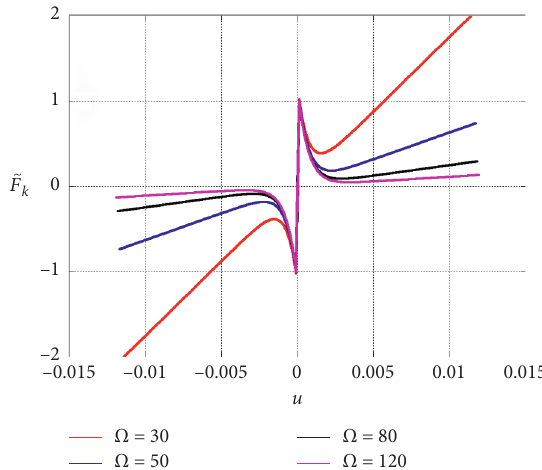
Figure 8: Absolute acceleration shock spectrum of the NSA. (a) Different shock excitation amplitude % F , % A � 1, μ � 6 . 7 × 10 − 4 , ζ � 0. (b) Different preload amplitude % A � 1, μ � 6 . 7 × 10 − 4 , % F � 50, ζ � 0. (c) Different fitting values μ , % A � 1, % F � 50, ζ � 0. (d) Different damping ratio μ � 6 . 7 × 10 − 4 , % A � 1, % F � 50 ( w � 200 π /s).